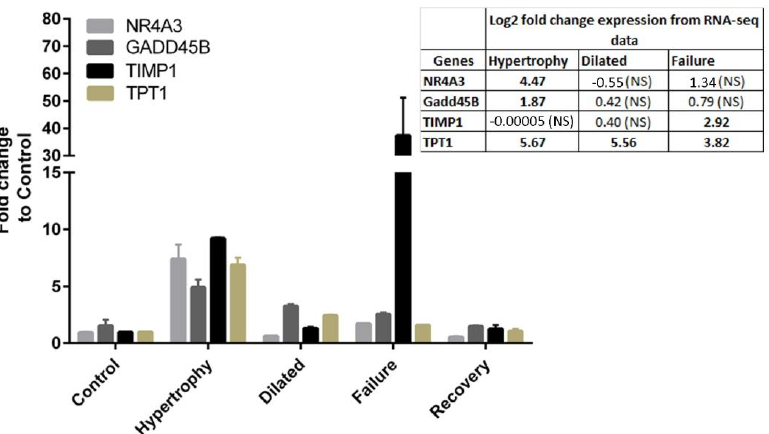
Figure 3. Validation of gene expression by real-time qRT-PCR analysis. The expression of four genes was analysed by qRT-PCR as GAPDH as the housekeeping control gene. The inset table shows the fold change values in the RNA-seq data. NS; non significant.